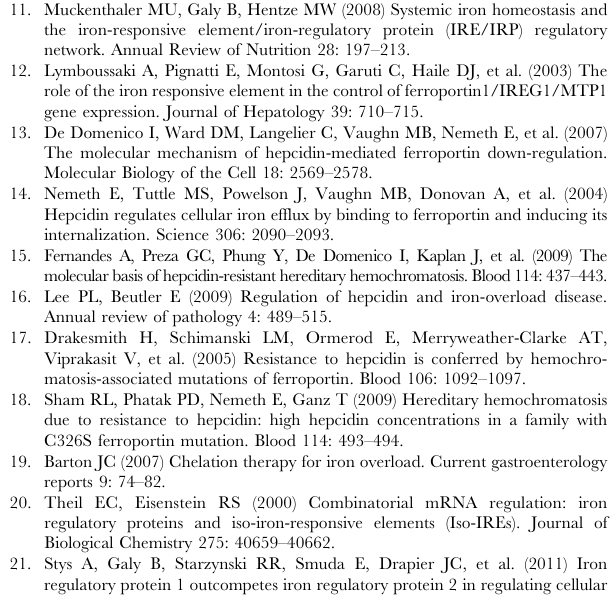
Figure S2 (A–B) Predicted iron-relevant mRNA targets of significantly upregulated (A) and downregulated. (B) microRNAs (listed in Table S1). (C) Quantitative real-time PCR (QRT-PCR) analysis of miR-149, miR-502-3p, and miR-30a* expression in K562, HEL, and HEK-293 cells after treatment with 100 m M deferoxamine (DFE), relative to baseline control. Data expressed as fold change in expression relative to RNU48 control (n =4). (D) Quantitative real-time PCR (QRT-PCR) analysis of miR-485-3p expression in human primary macrophages after treatment with 100 m M deferoxamine (DFE), relative to baseline control. Data expressed as fold change in expression relative to RNU48 control (n =6). (E) Fold change in luminescence of FPN 3 9 UTR luciferase reporter in K562 cells co-transfected with miR-485 expression construct (pc-miR-485) (left) or miR-194 (pc-miR-194), expressed as fold change 6 SEM relative to vector control (pc-vector) (n =3). (F) Fold change in luminescence of FPN 3 9 UTR luciferase reporter co-transfected with antisense-mediated oligonucleotides (AMOs) against miR-485-3p (AMO-485-3p) expressed as fold change 6 SEM relative to control AMOs (AMO-CNTL1, AMO- CNTL2)(n =3). * Significantly different by Student’s t-test: